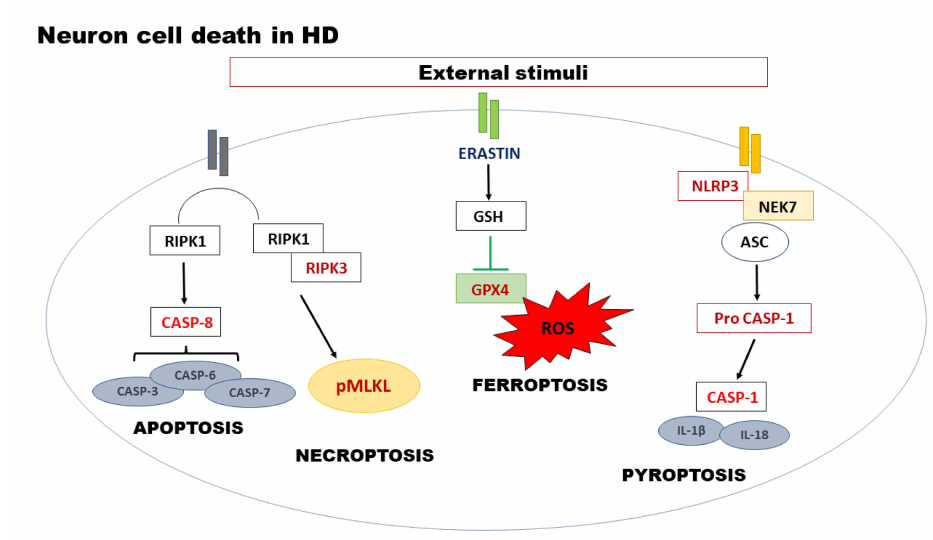
Figure 1. Schematic overview of cell death pathways. Neuron cell death is triggered by various external stimuli, which determine the activation of the different programmed cell death characterized by the activation of own